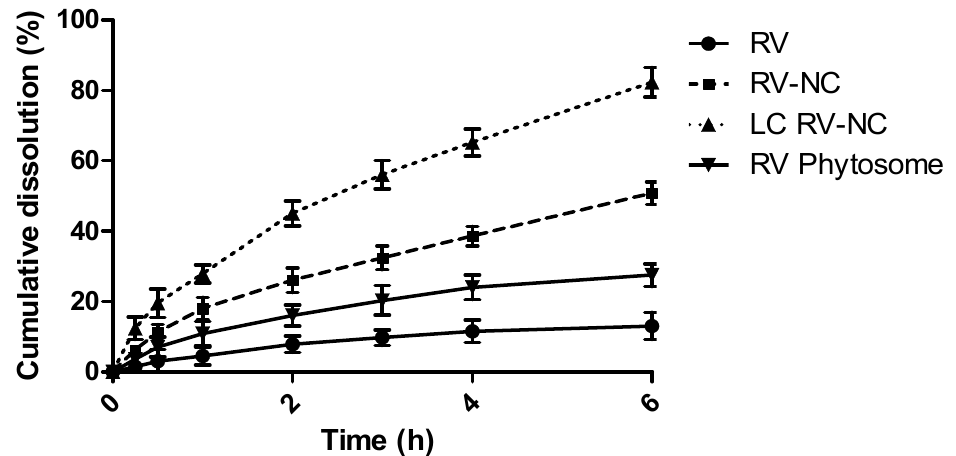
Figure 3. In vitro dissolution profiles of the trans -resveratrol NCs (RV-NC) and lipid-coated trans -resveratrol NCs (LC RV-NC) in comparison with the coarse resveratrol powder (RV) and RV Phytosome ® .